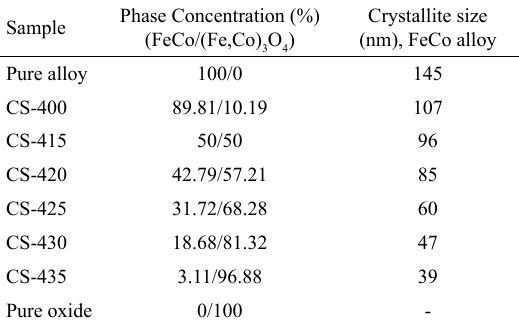
Table 2. Quantitative results obtained using Rietveld refinement.